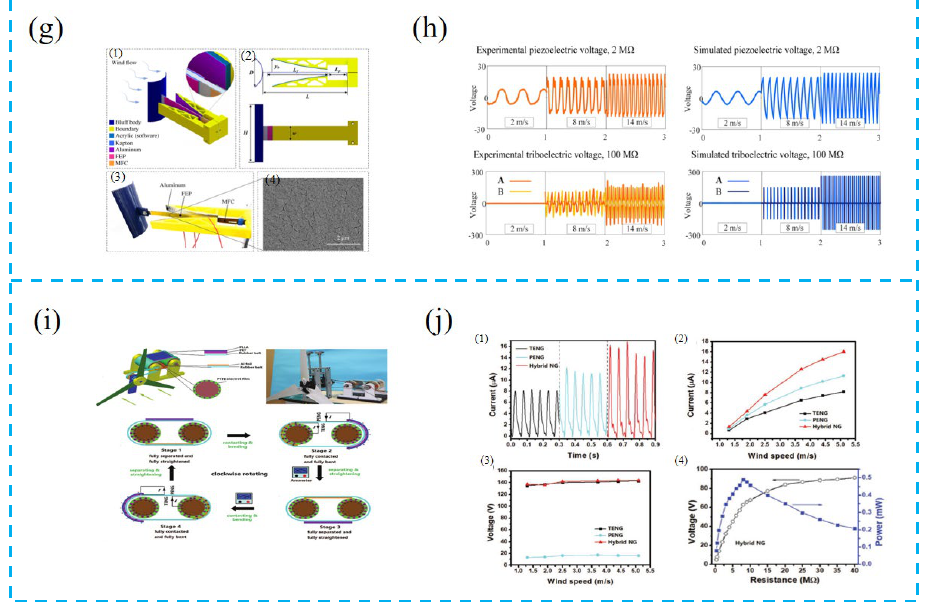
Figure 9. ( a ) Digital photo and cross-sectional digital photo of the hybrid nanogenerator. ( b ) Average instantaneous rectifier output current and output voltage at different frequencies. ( c ) Photo of a boat with incorporated BCHNG modules in a water tank, and state-of-the-art performance of the device structure with the wave energy harvesting. ( d ) Output performance of different parts of the hybrid nanogenerator plotted in simulated water waves. ( e ) 3D representation of the custom-made setup for simulating rainfalls. ( f ) ( 1 ) Open-circuit voltage of the HNG under the impact of single 100 μL water droplets. ( 2 ) Open-circuit voltage of the HNG under the impact of single raindrops at different frequencies in the range of 2–12 Hz. ( 3 ) Open-circuit voltage of the HNG under simulated rainfalls after the first impact with water and after 1/2 h of continuous water falling. ( 4 – 6 ) Open-circuit voltage of the HNG under simulated rainfalls for ( 4 ) different flow rates, ( 5 ) different heights, and ( 6 ) different inclination angles of the HNG with respect to the vertical direction. ( g ) ( 1 ) Design of a synergetic PTCNG wind energy harvester (SHPTWEH), ( 2 ) its geometric configuration, ( 3 ) the prototype, and ( 4 ) an SEM image of the FEP used in the device. ( h ) The voltage response of the SHPTWEH at different wind speeds obtained from experiments and simulations, respectively. ( i ) Schematic diagram of the structure, photograph of the hybrid nanogenerator ( left and right ), and the working principle of the PTCNG. ( j ) ( 1 ) Real-time I sc measurement of the E-TENG, PENG, and hybrid NG at a wind speed of 5.1 m s −1 . ( 2 ) Rectified I sc as a function of wind speed for the E-TENG, PENG, and hybrid NG. ( 3 ) Voc of the E-TENG, PENG, and hybrid NG as a function of wind speed. ( 4 ) The output voltage and output power as a function of load resistance for the hybrid NG.